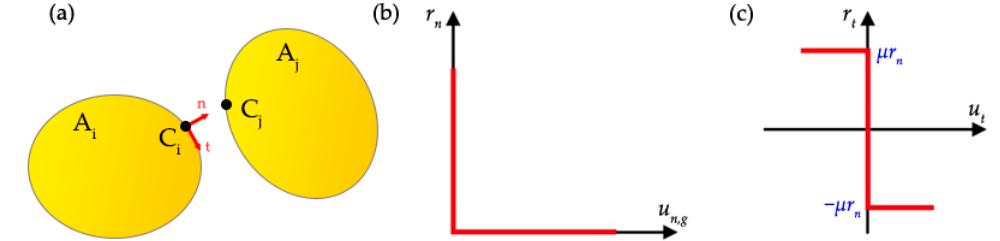
Figure 5. Bodies in possible contact in a plane ( a ), the Signorini’s ( b ) and dry-friction Coulomb’s ( c ) laws.